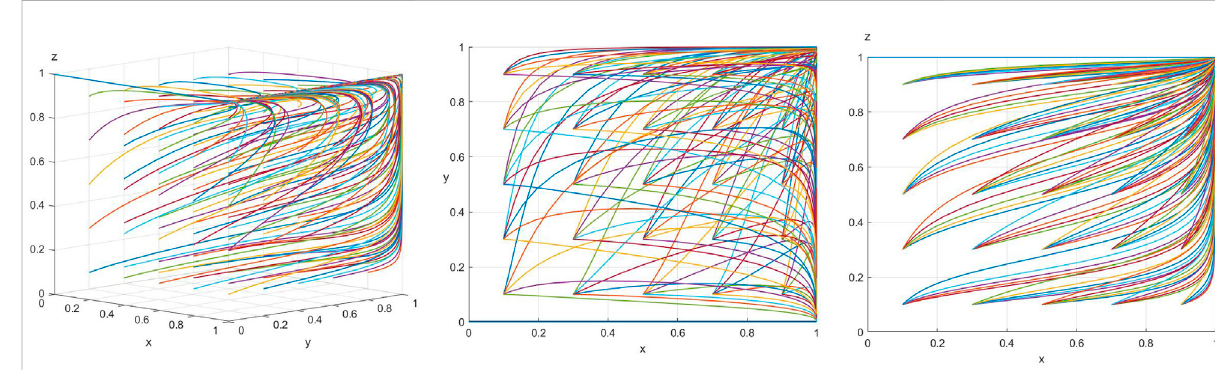
FIGURE 3 Results of the simulation evolution of array I.